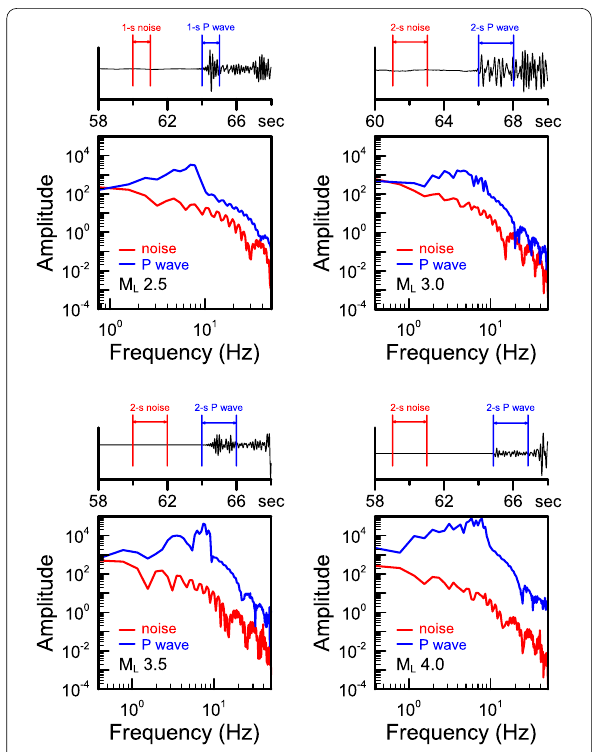
Fig. 2 Example of noise test at station NACB for 2.5 < M L < 4.5 events to examine the frequency range (FR) used for the follow‑up analysis. Obviously, small‑sized events have a relatively narrow FR. For M L 4.0, ≥ 3.5 M L < 4.0, 3.0 M L < 3.5, and 2.5 M L < 3.0 events, FR 0.1–10 Hz, ≤ ≤ ≤ = 1–10 Hz, 2–10 Hz, and 3–8 Hz,